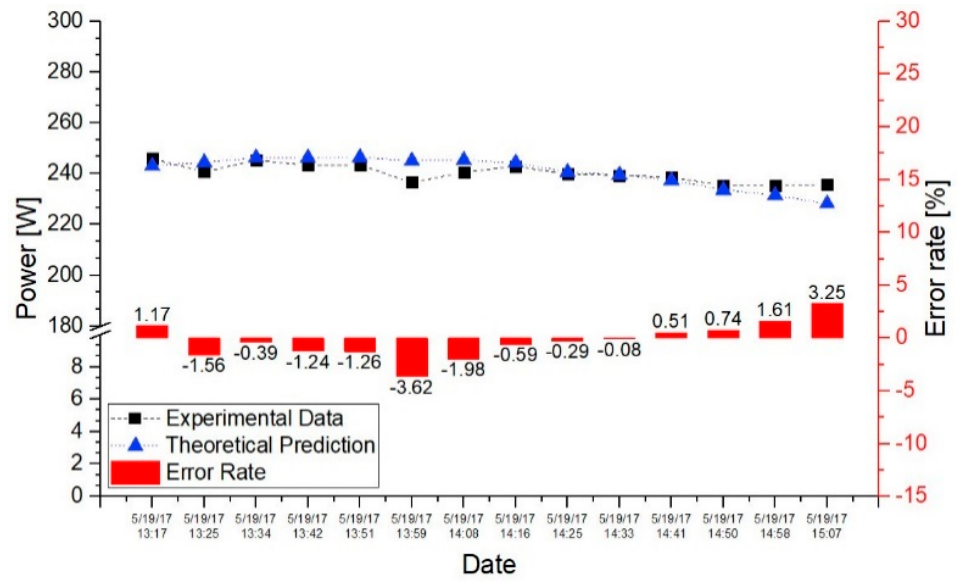
Figure 13. Experimental data of Exp. 3.